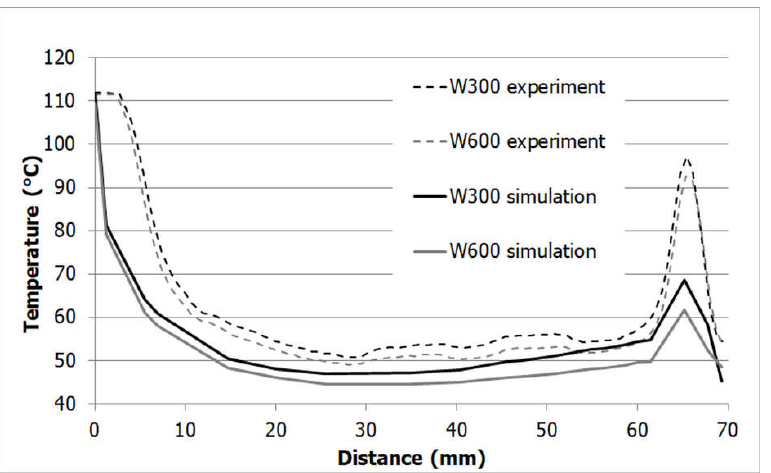
Figure 10. Comparison of part temperature from experiment and simulation for a PP for a 1 mm box on a diagonal line from the center of the part to one corner.